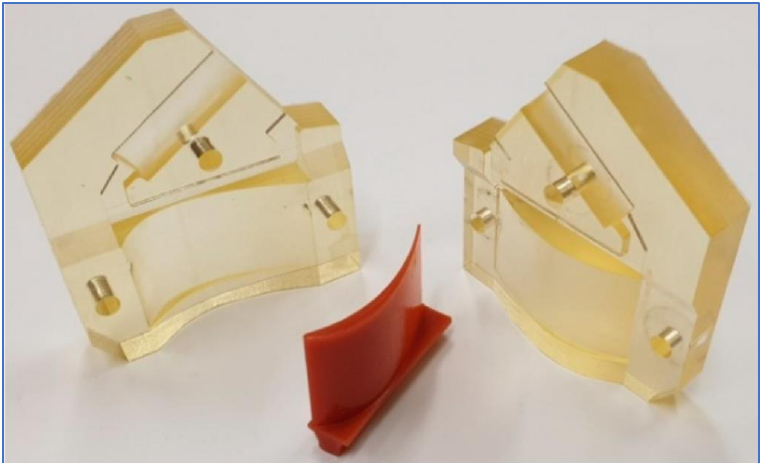
Figure 5. Wax turbine blade from MJ printed molds [106].